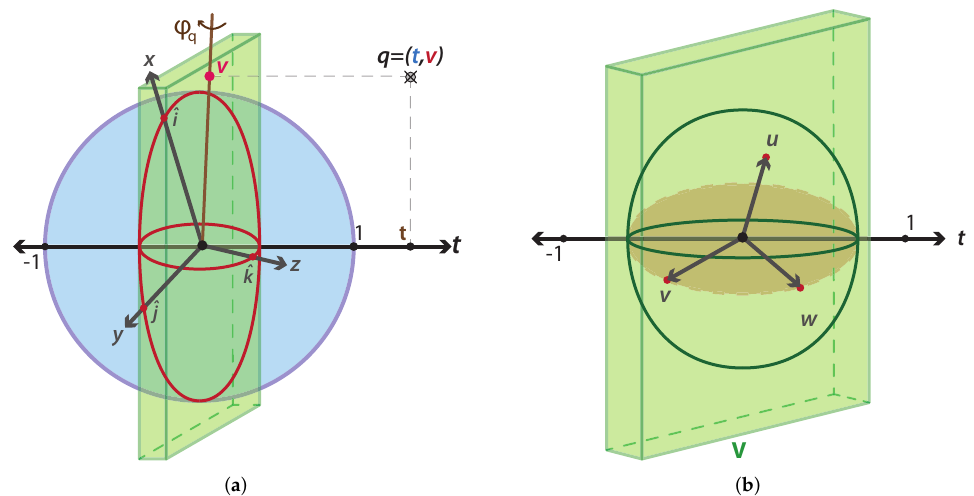
Figure 1. Representation of four-dimensional space. ( a ) 4D space where the blue sphere represents an S 3 sphere, the red sphere describes an S 2 sphere, and q is a quaternion on the 4D space. ( b ) 4D space where the V space in green is equal to a 3D space and the t-axis is orthogonal to this space. Quaternion multiplication is not commutative, and it follows the rules: